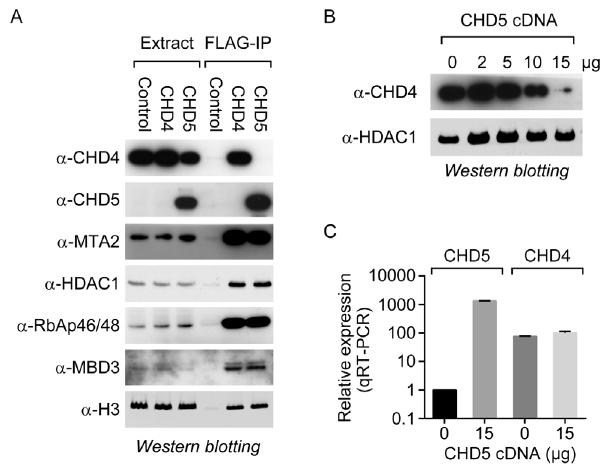
Figure 1. CHD5 co-purifies with the NuRD transcriptional repressor complex. (A) FLAG-tagged CHD4 and CHD5 were immunoprecipitated from a transiently transfected HEK293T-derived cell line, and the samples were analyzed by western blotting using the indicated antibodies. The empty vector was also transfected in parallel [Control]. (B) The HEK293T-derived line was transiently transfected with increasing amounts of the CHD5-expression plasmid. An empty vector was included where necessary to keep the final amount (15 m g) of transfected plasmid constant. Following transfection, cell extracts and RNA were prepared to measure CHD4 levels by western blotting and CHD4 and CHD5 mRNA levels by qRT-PCR.